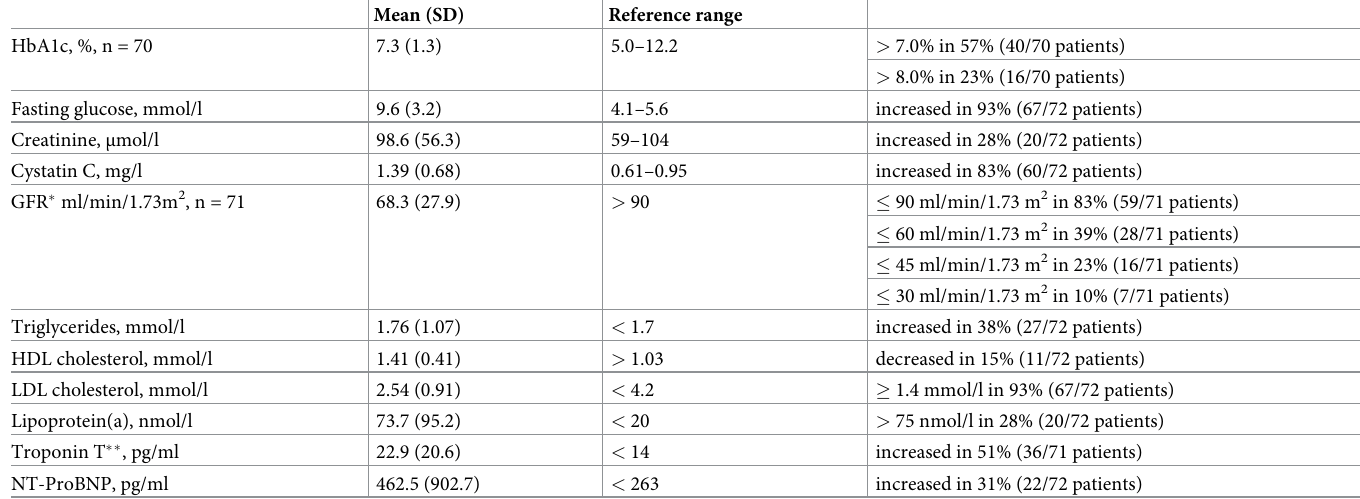
Table 4. Laboratory parameters, n = 72.